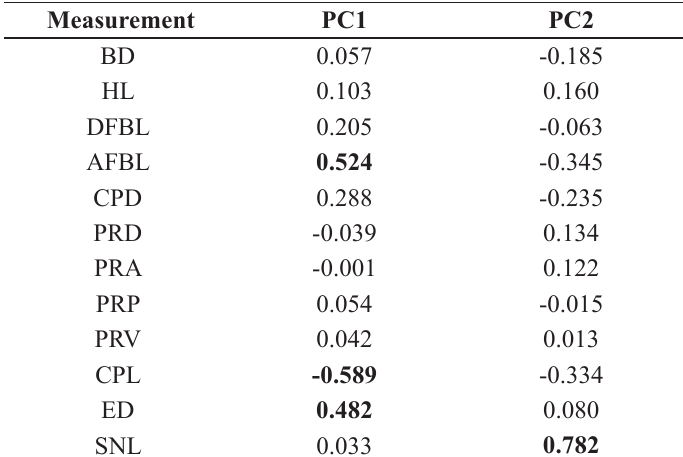
Table 4. Principal Component Analysis factor loadings. The variables contributing most substantially to the two axes (< -0.4 and > 0.4) are highlighted in